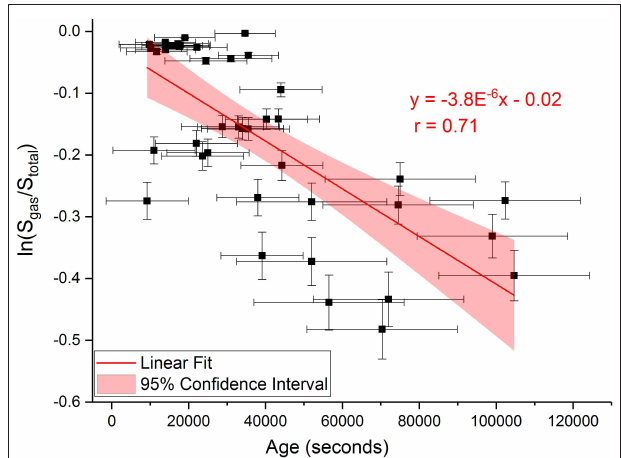
FIGURE 5 | Relationship between the age of the volcanic cloud and the volcanic sulfur components measured at P ¯ ahala, Ocean View and Kona HDOH ambient air quality stations. S gas is the sulfur component of the volcanic SO 2 mass concentration, S total is the sum of sulfur components of the volcanic SO 42– and SO 2 mass concentrations. Age is derived from HYSPLIT back-trajectory simulations (Ilyinskaya et al., in preparation). Y axis error bars indicate range of SO 42– component in volcanic PM 2.5 composition from K ¯ ılauea. X axis error bars indicate one standard deviation of HYSPLIT back-trajectory results specific to Kona, Ocean View and P ¯ ahala. Correlation trendline based on the data points, with a first-order decay constant of 3.8 x 10 –6 s –1 with a 95 % confidence interval of ± 1.26 x 10 –6 s –1